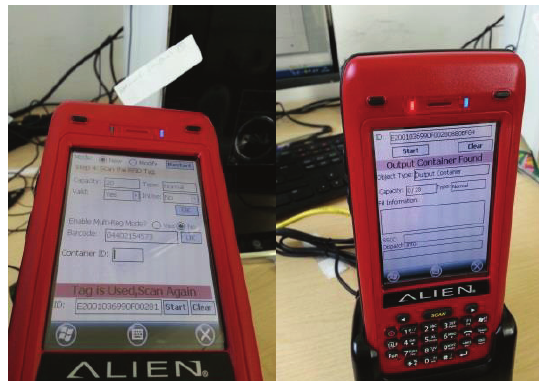
Fig. 9 Handheld Device and Application